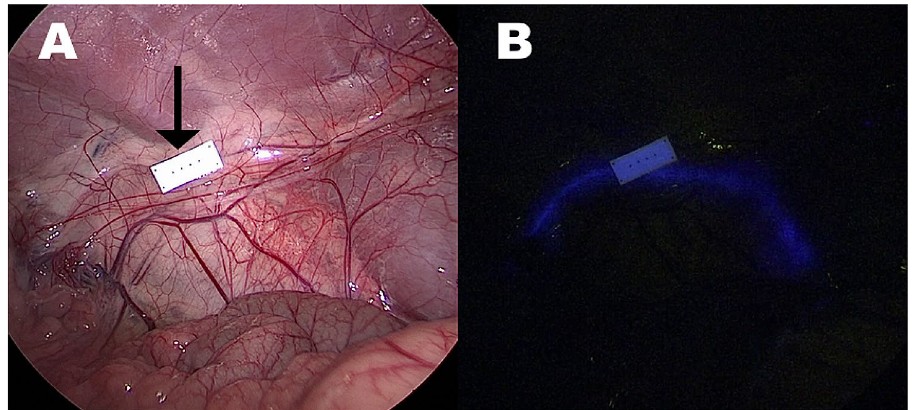
Figure 2. Demonstration of a NICE-coated catheter under white light ( A ) and near-infrared mode ( B ). The arrow highlights the fluorescence reference card. Differently from humans, the ureter is already visible under white light in pigs due to the thin overlying